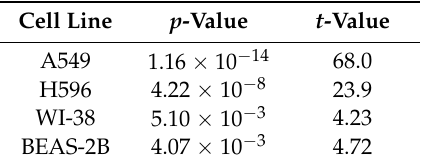
Table 6. Comparison of no treatment group with liposomes containing both phenethyl isothiocyanate (PEITC) and cisplatin (CDDP) (Lipo-PEITC-CDDP) on cancer and normal cell